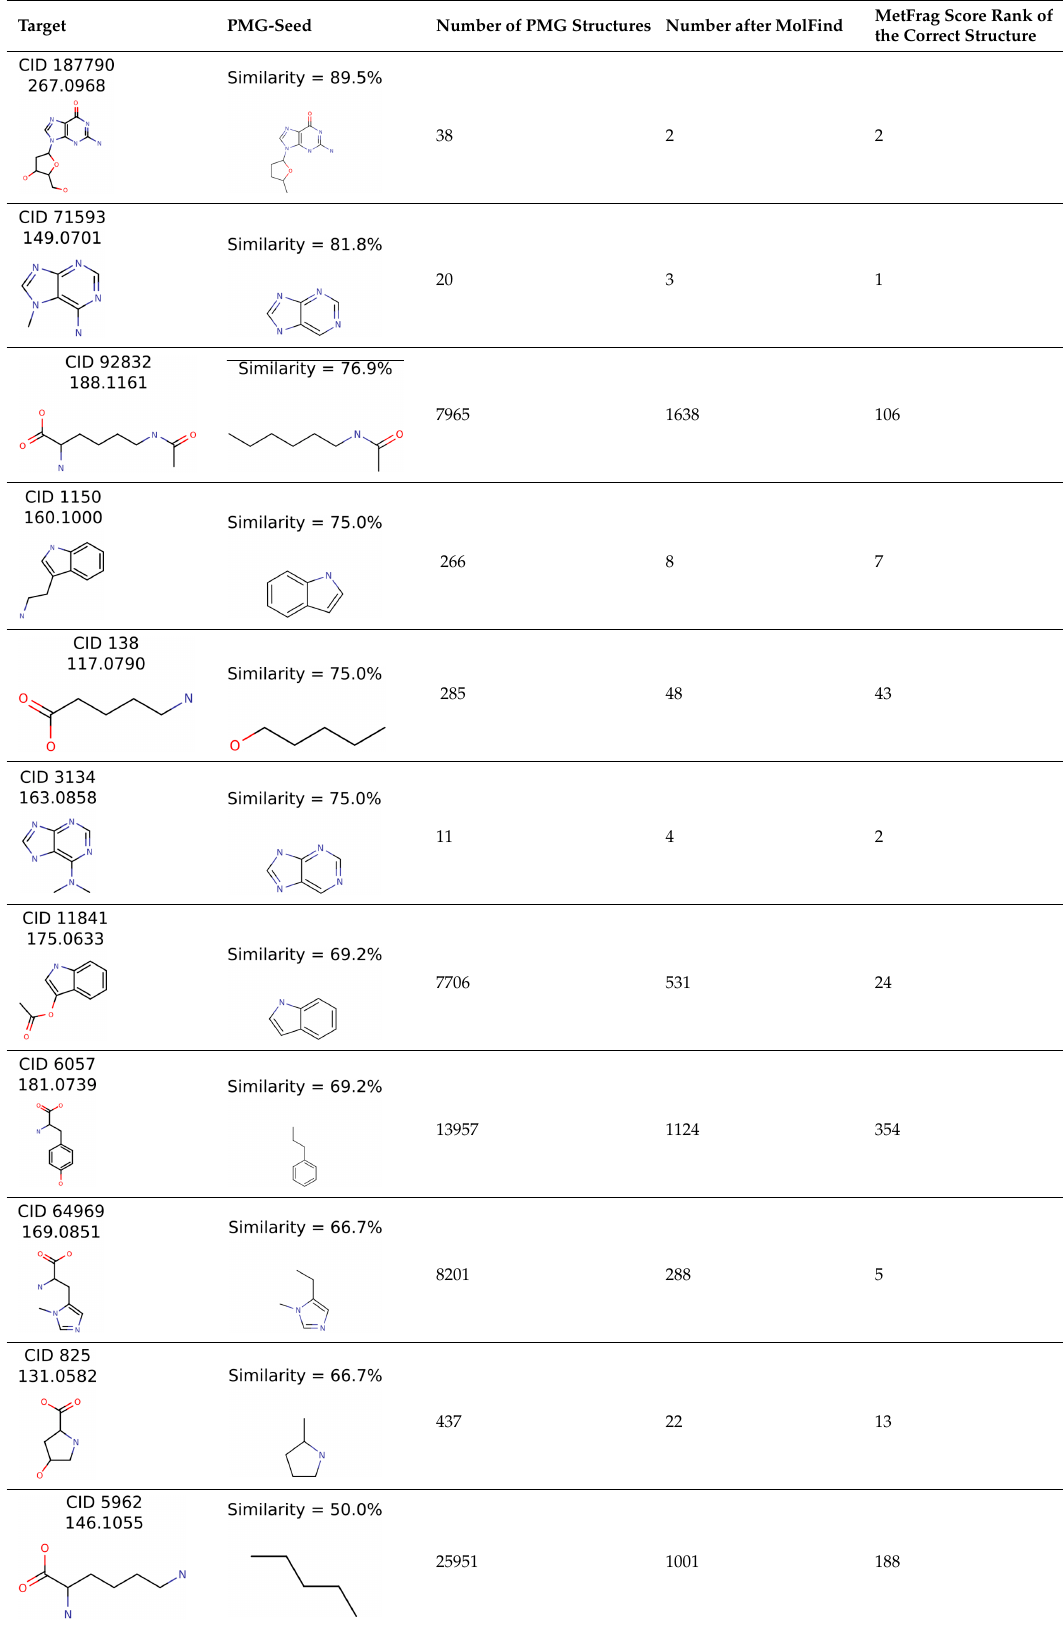
Table 3. Putative unknowns identified with Algorithm-3-6.